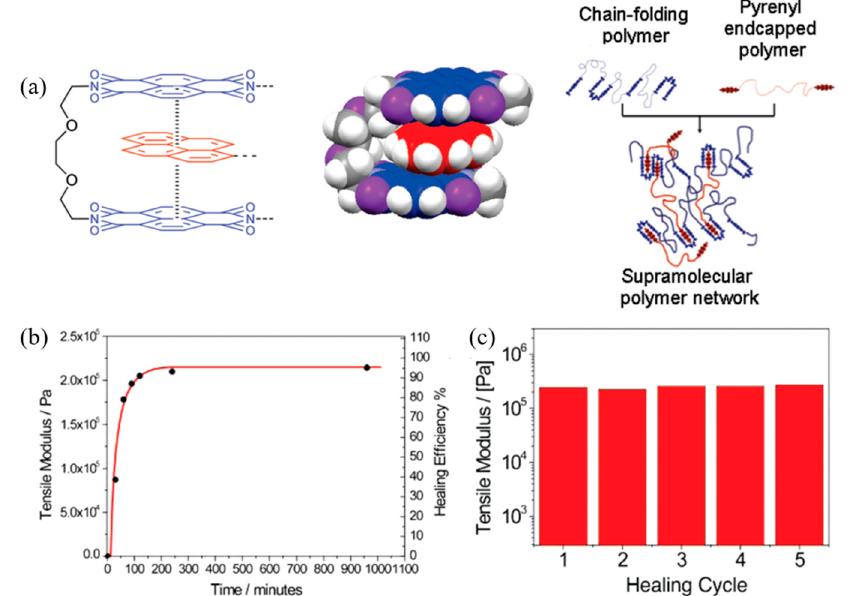
Figure 16. The supramolecular polymer network with π – π interaction; ( a ) π – π interaction mechanism of pyrenyl polymer and aromatic ring in chain-folding polymer, ( b ) tensile modulus and healing efficiency as function of time, and ( c ) tensile modulus under five breaks-heal cycles [102]. Adapted with permission from [102]. Copyright 2010 American Chemical Society.